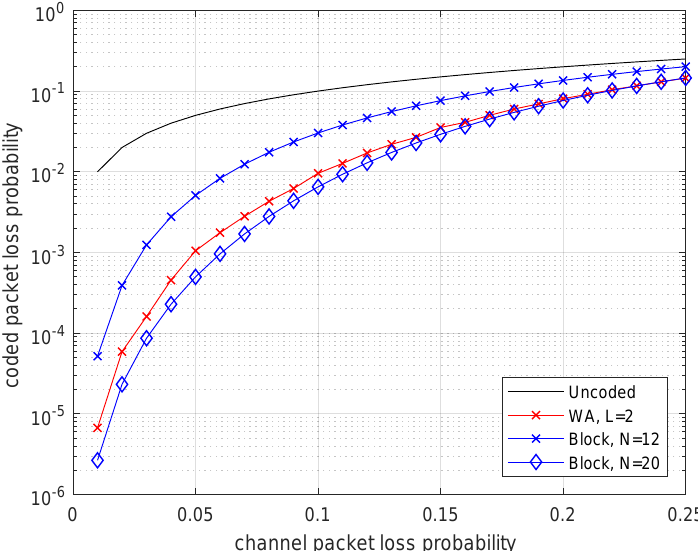
Figure 6. Comparison of rate 3/4 block codes and the WA convolutional code for different decoding